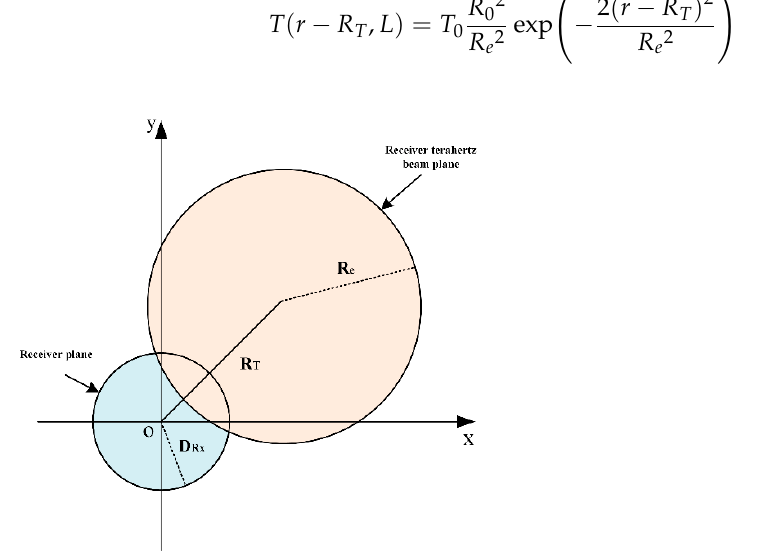
Figure 7. Schematic diagram of beam trajectories caused by pointing errors in the receiver plane. h err ( θ ) is the signal power attenuation considering the pointing error, expressed by Equation (16), which is a function of the pointing error angle. The larger the value of h err ( θ ) , the smaller the influence of the pointing error; the smaller the value of h err ( θ ) , the greater the influence of the pointing